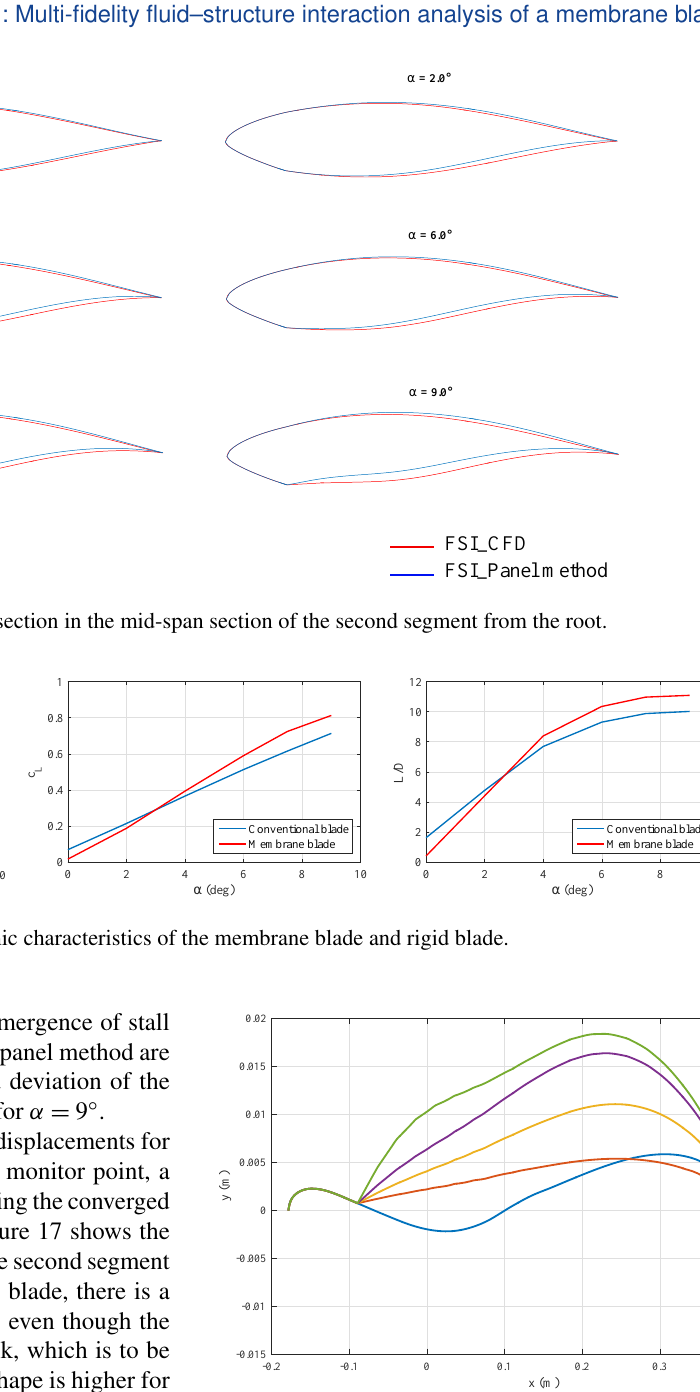
Figure 19. Comparison of the camber line in the middle span sec- tion of the second segment from the